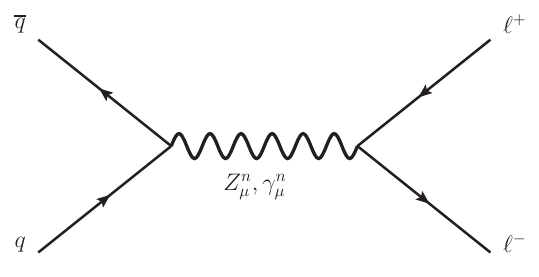
Figure 9 . Diagrams contributing to the process (cid:27) ( pp